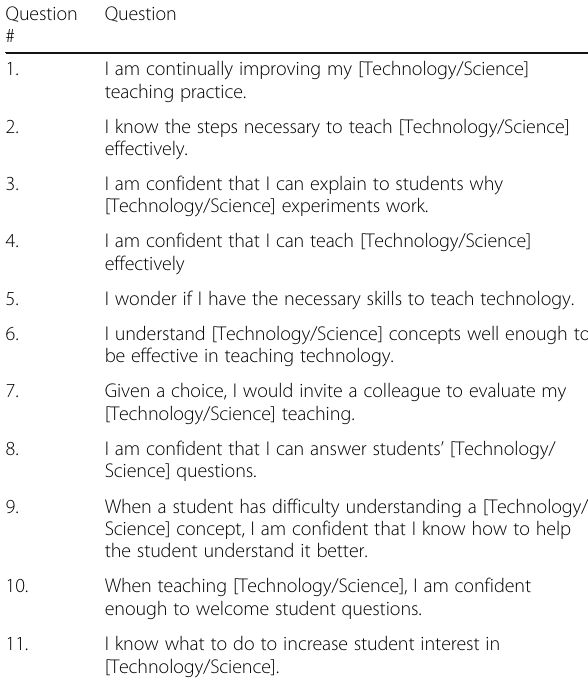
Table 4 Self-efficacy: personal STEM teaching efficacy and